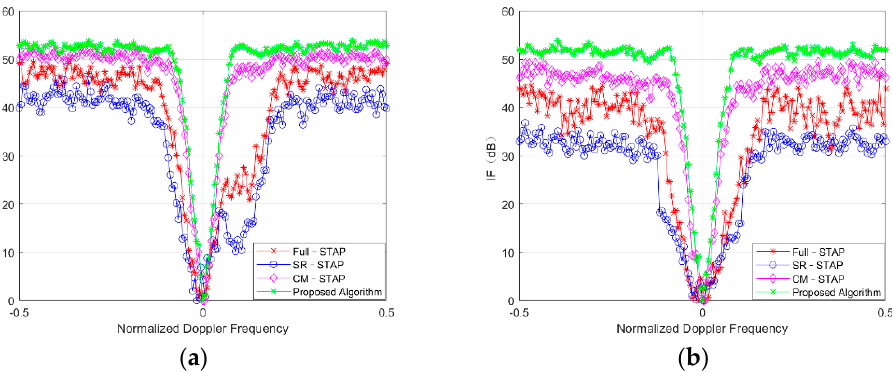
Figure 4. Comparison of improvement factor (IF) with different algorithms in ( a ) scene 1 and ( b ) scene 2. ( b ) scene 2.